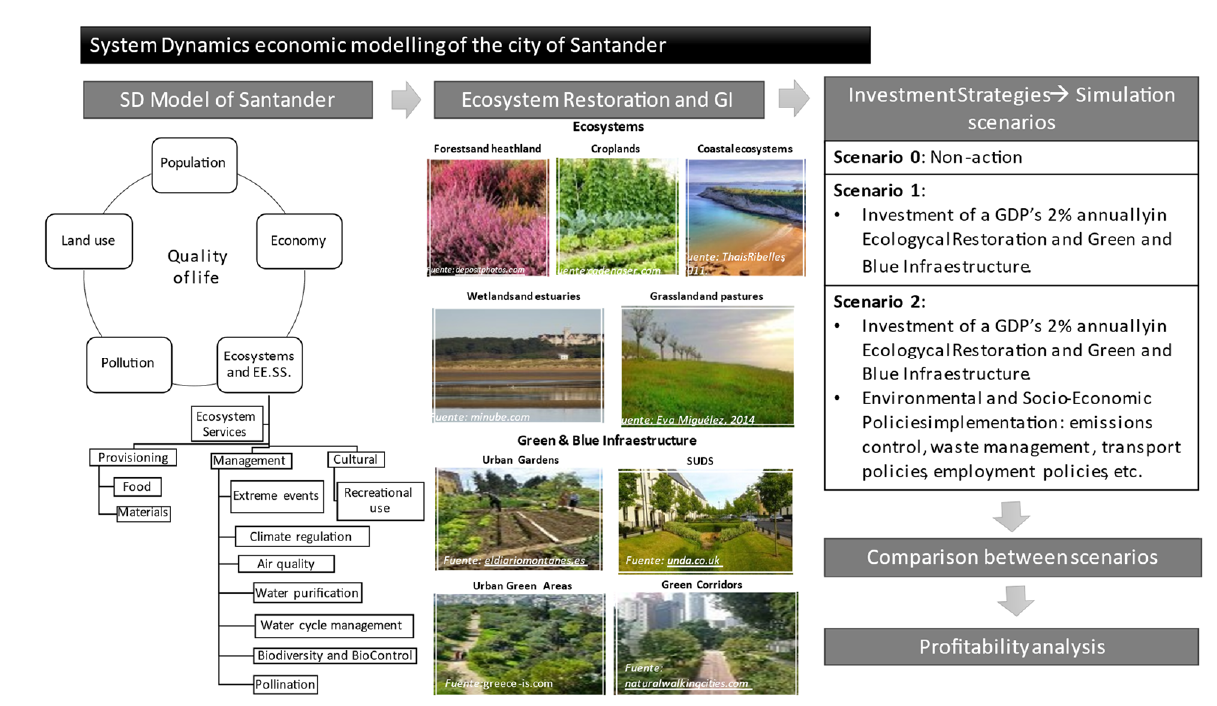
Figure 2. Schematic diagram of the steps in the methodology followed in this study. It illustrates the main components of the SD model of the city of Santander and emphasizes the principal ecosystems and GI elements present in the study area to consider in the modelling process. It also states the different scenarios simulated representative of the investment strategies considered, and the following comparison and analysis of the profitability of the investment and policies proposed (own elaboration).